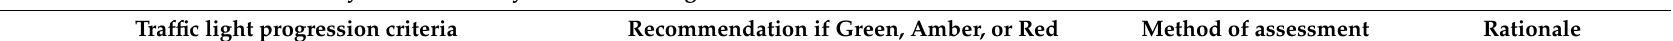
Table 3. Study criteria for progression to a powered effectiveness evaluation. Feasibility and Pilot Study Criteria for Progression to a Powered Effectiveness